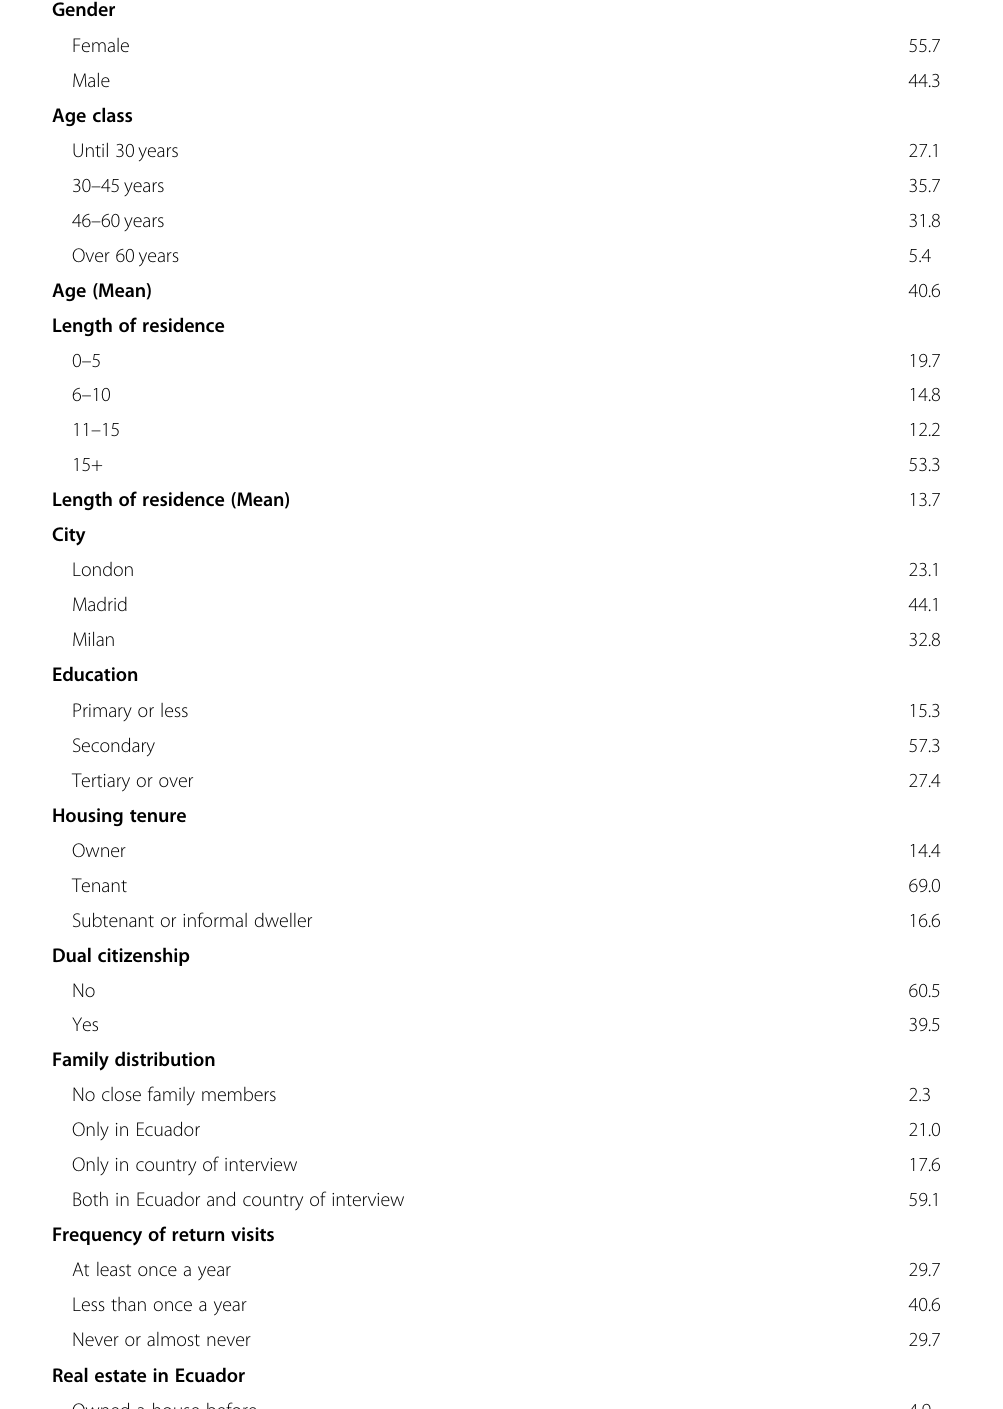
Table 1 Frequency distribution of independent